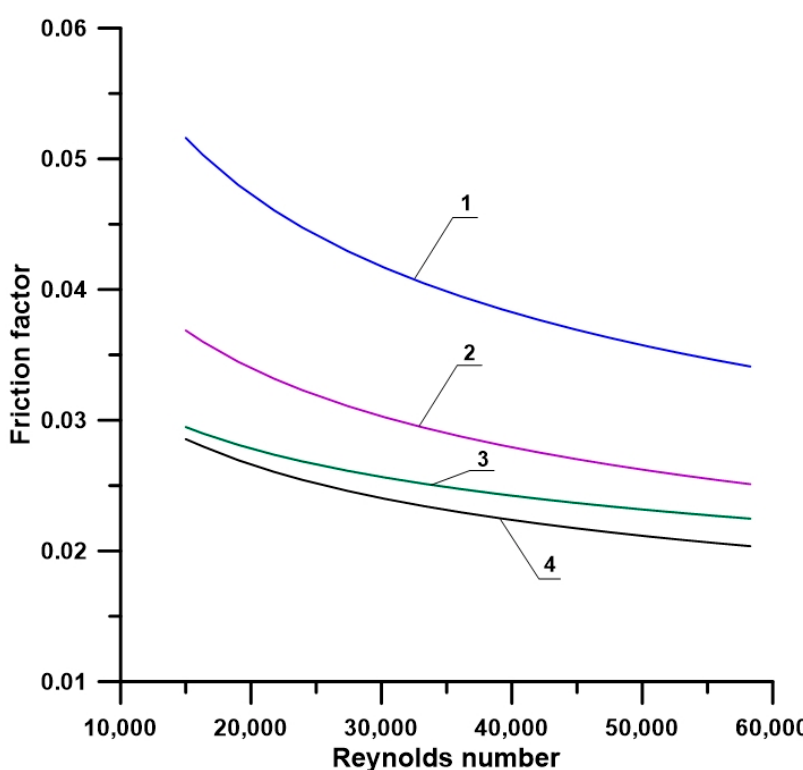
Figure 2. Comparison of the friction factor curves plotted for tubes with internal helical ribs and smooth tubes. Regarding internally ribbed tubes: 1—Equation (11); 2—Equation (14); 3—Equation (9). Regarding smooth tubes: 4—Equation